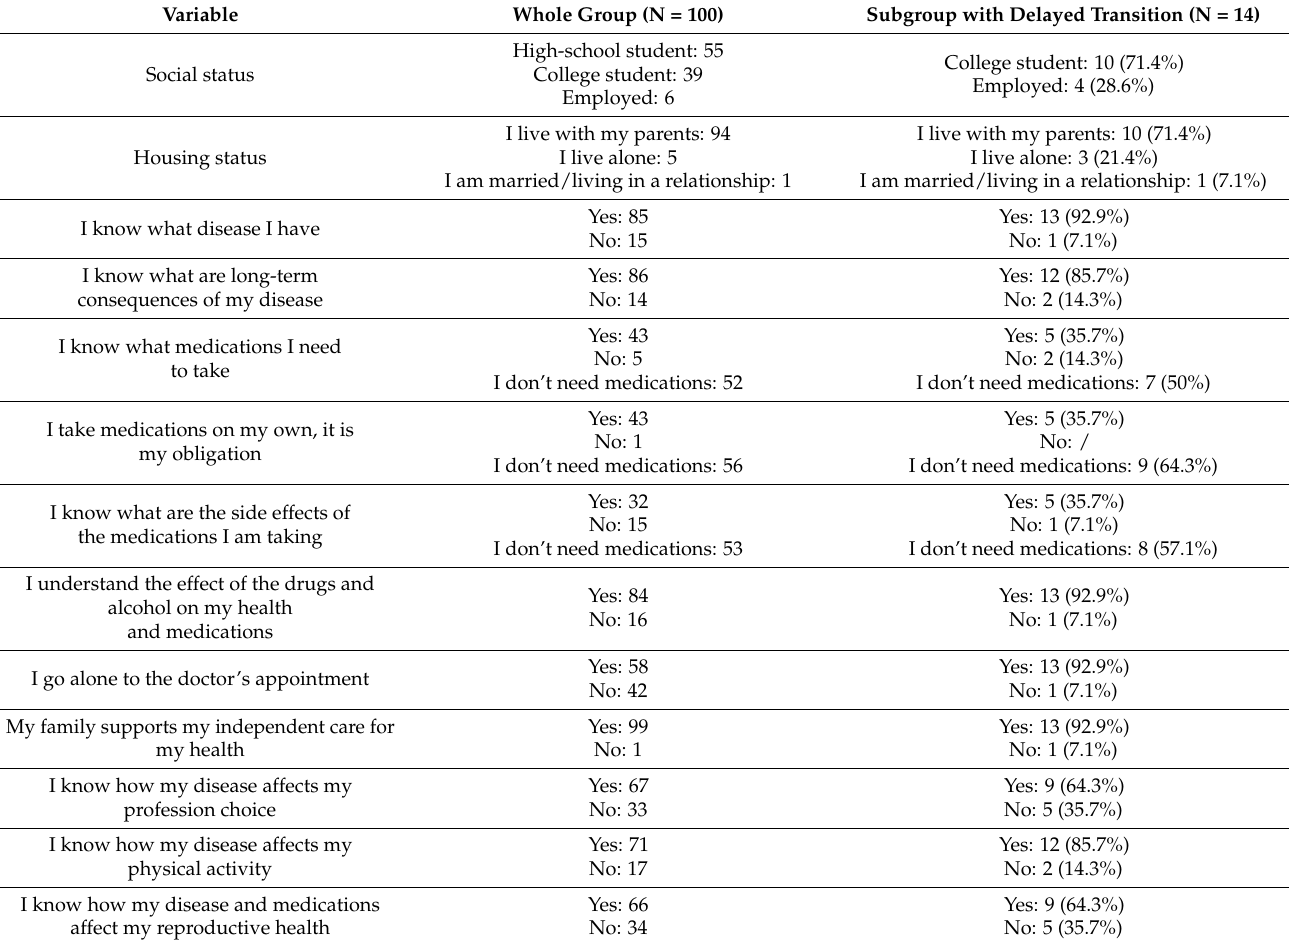
Table 1. Results of the questionnaire, presented as N of the checked answers =